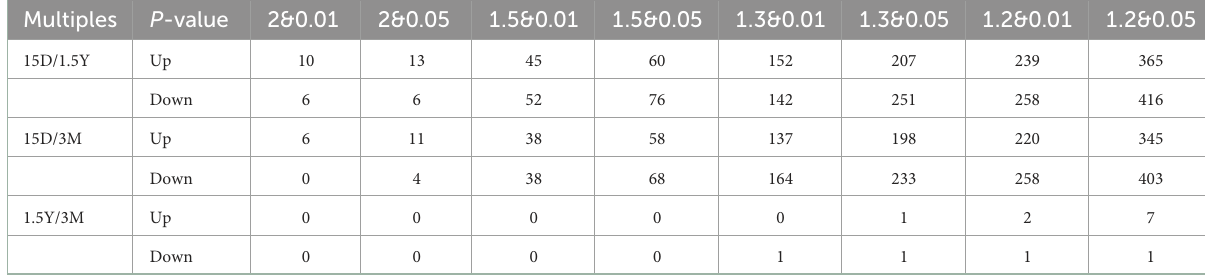
TABLE 1 Quantity sheet of differential proteins between different groups at different multiples and P values.